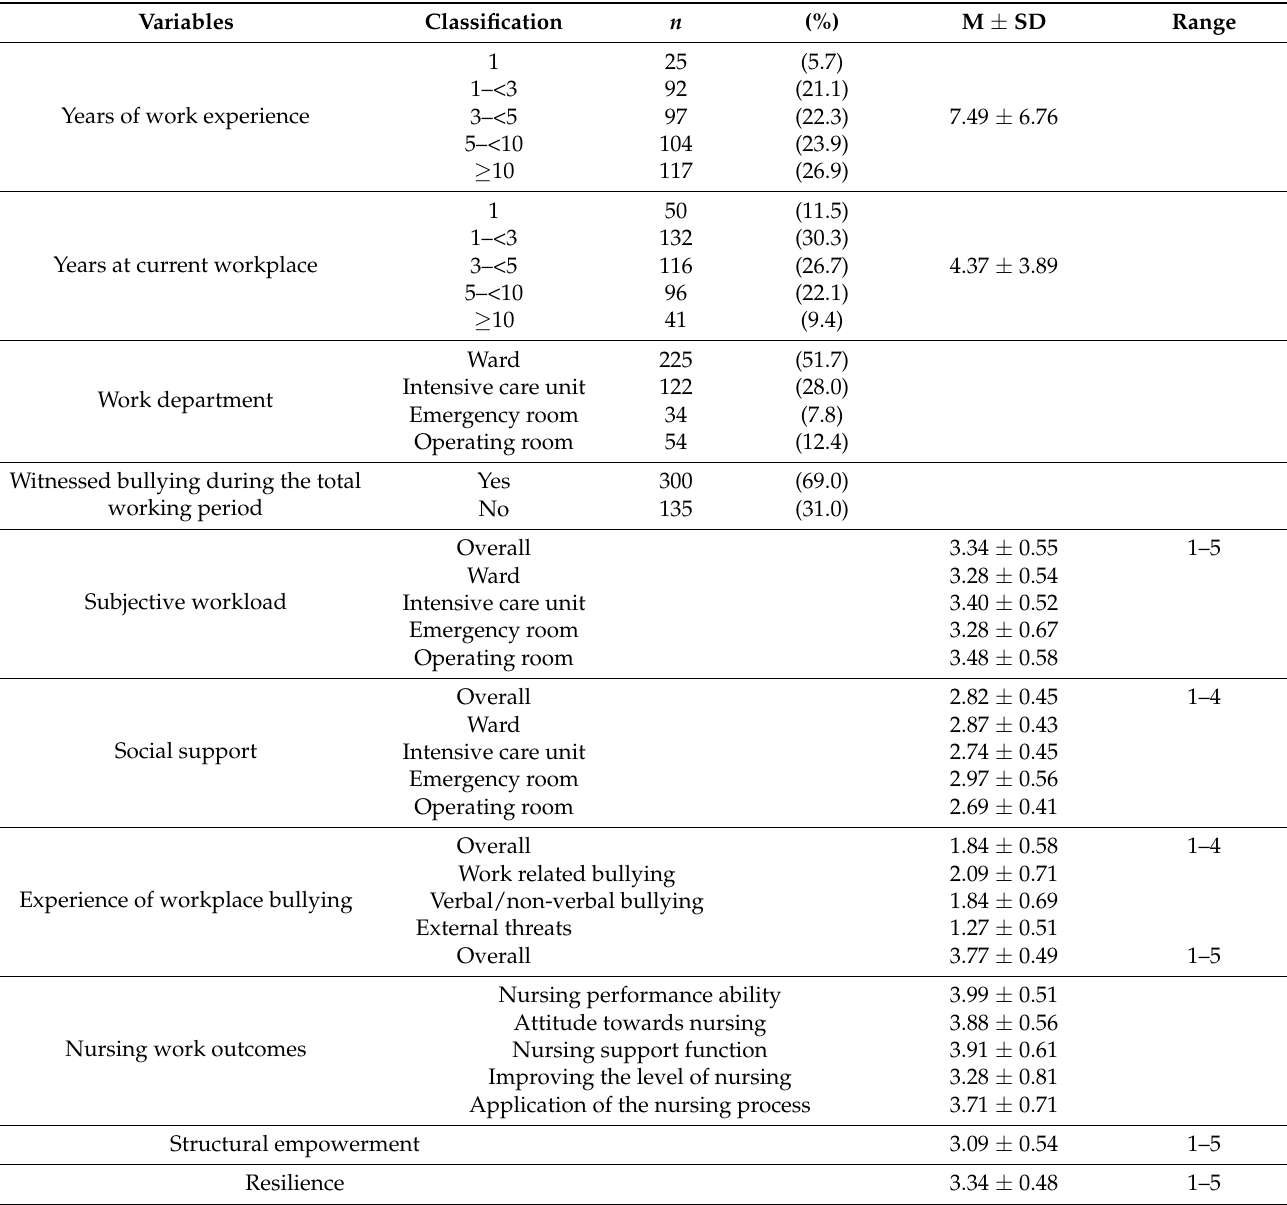
rience, 3.77 (SD = 0.49) for nursing work outcomes, 3.09 (SD = 0.54) for structural empower- ment, and 3.34 (SD = 0.48) for resilience. Work-related bullying was the most frequently re- (mean ± SD = 1.84 ± 0.69) and external threats (mean ± SD = 1.27 ± 0.51). Regarding nurs- ing work outcomes, nursing performance ability was highest (mean ± SD = 3.99 ± 0.51), followed by nursing support function (mean ± SD = 3.91 ± 0.61), attitude towards nursing (mean ± SD = 3.88 ± 0.56), the application of the nursing process (mean ± SD = 3.71 ± 0.71), and improving the level of nursing care (mean ± SD = 3.28 ±